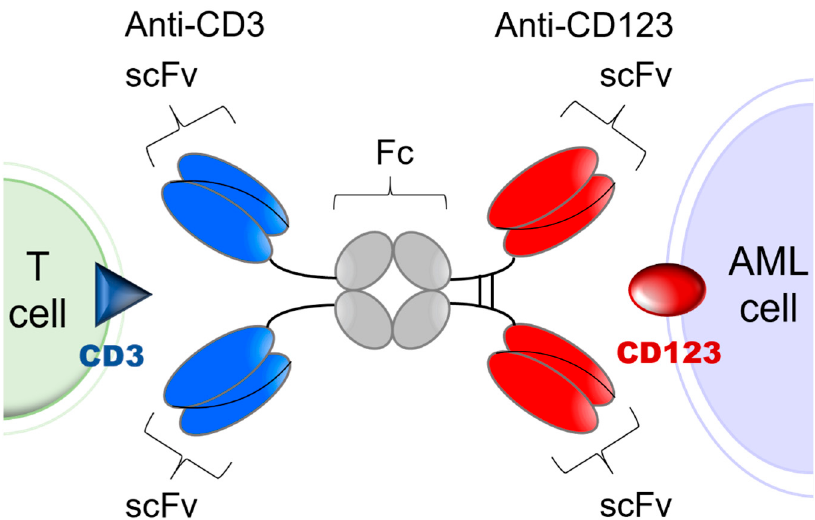
Figure 1. Simplified schematic explaining the mode of action of APVO436. APVO436 targeting CD123 on AML cells and redirecting CD3 + T cells to the close vicinity of the target leukemia cells. APVO436 is a humanized bispecific antibody that targets both CD123 and CD3. It is composed of two sets of binding domains linked to a human IgG1 Fc domain. The CD123 binding domain is a fully human scFv directed against human CD123. The CD3 binding domain is a humanized scFv that binds human CD3. The Fc region has been engineered to minimize complement fixation and interaction with Fc γ receptors.